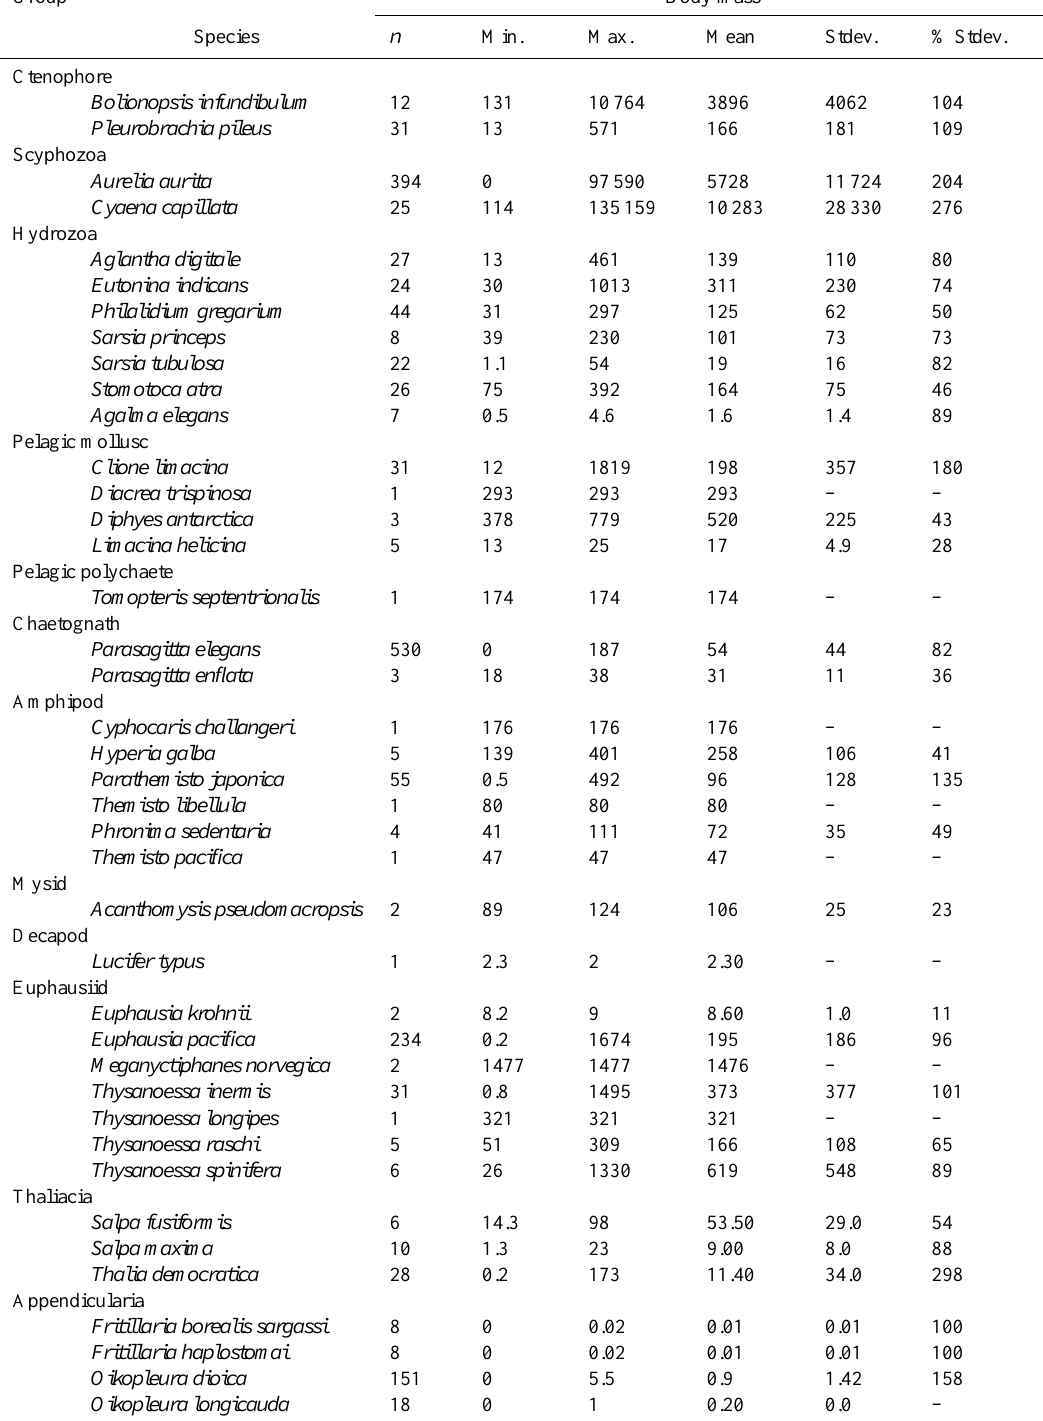
Table 2. Mean body mass values used to convert COPEPOD species abundance (ind.L − 1 ) to biomass ( µ molCL − 1 ). Notes: n = number of data points per species, Min. = minimum body mass, Max. = maximum body mass, Stdev. = Standard deviation; all body mass units are µ molC. Data from Hirst (2003) and Moriarty